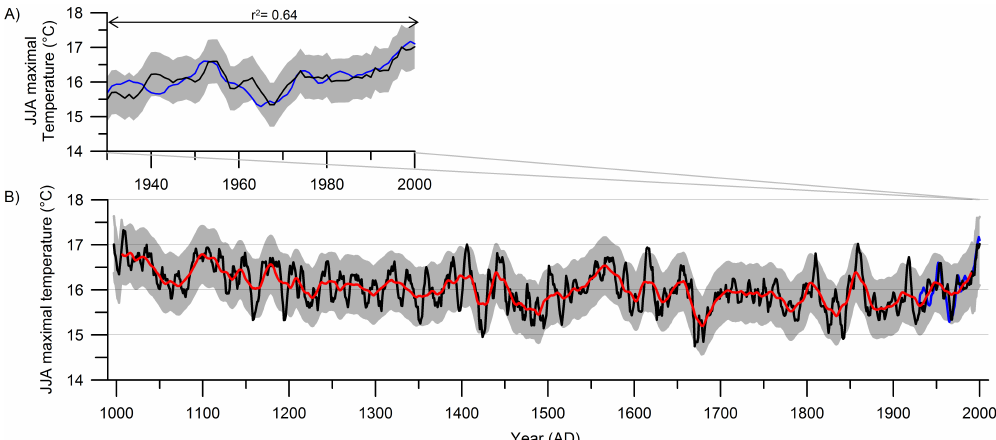
Figure 4. (a) Comparison between reconstructed (i-STREC, black line) and observed (blue line) JJA maximal temperature and mean square values on the entire period of calibration. (b) i-STREC (black line) with 21-year moving average (red line) and observed JJA maximal temperature series from CRU TS3.1 (blue line). In both cases, the dark gray shading represents uncertainty with ± 1 RMSE calculated on the 21-year filter